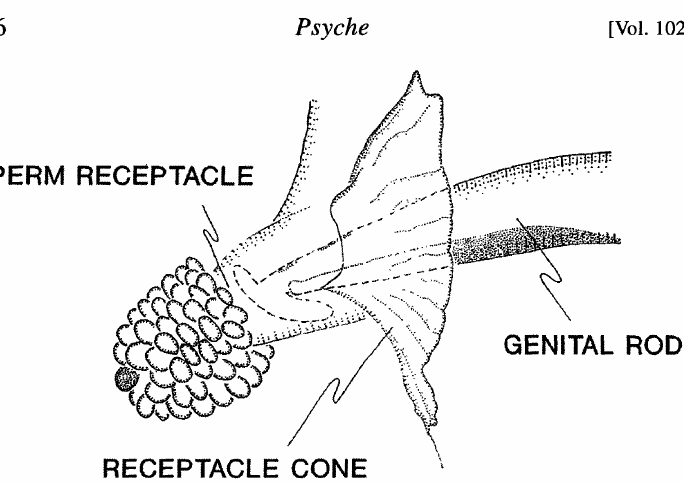
Fig. 13. Diagrammatic view of the male genital rod inserted into the female’s ventral receptacle. Note the distortion of the tip of the rod (compare with Figs.